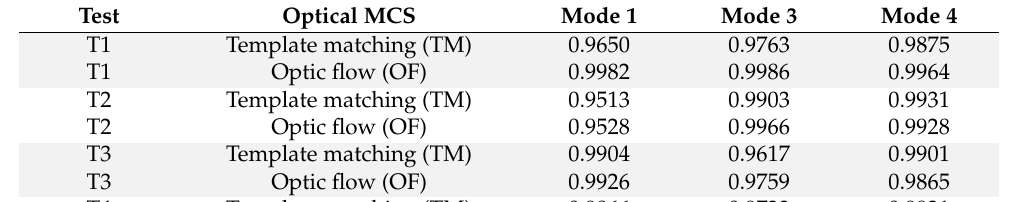
Table 4. Modal assurance criterion (MAC) for all tests.